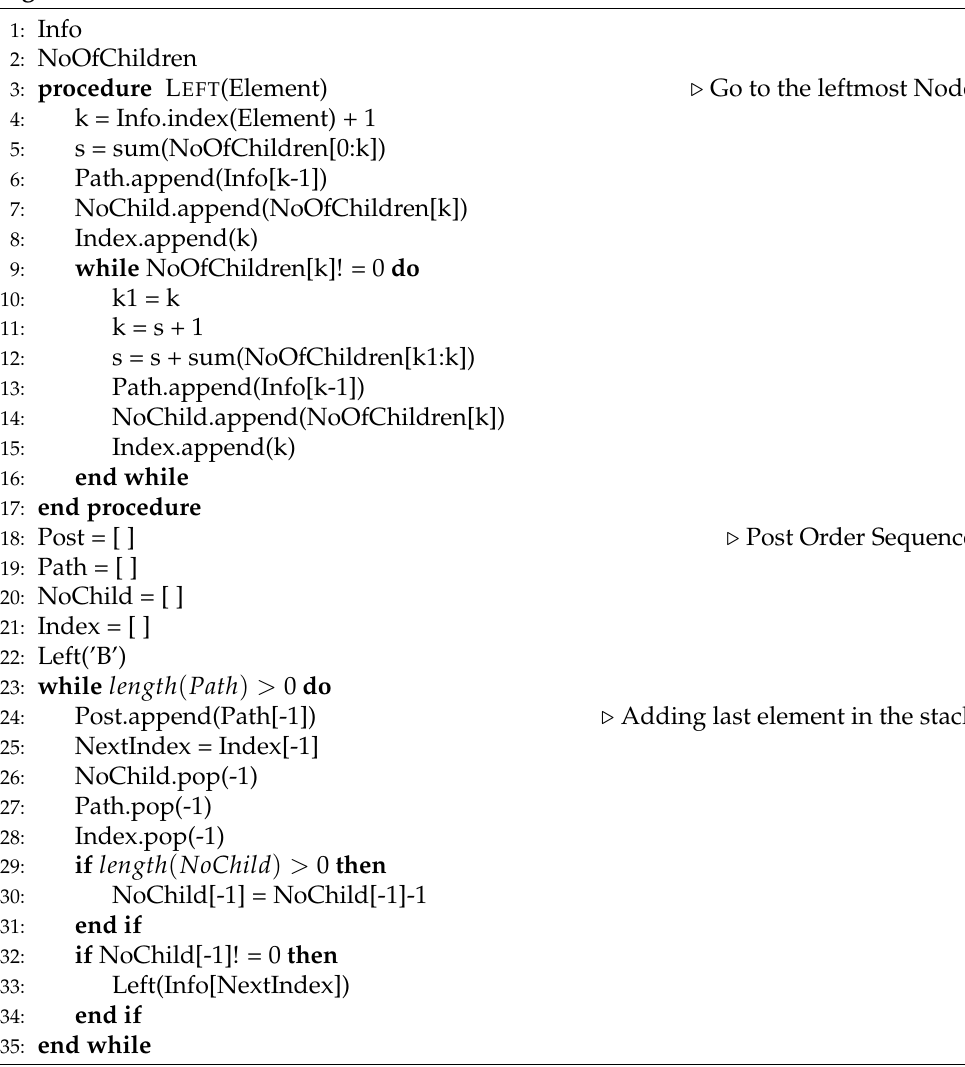
Algorithm 6 Post-order